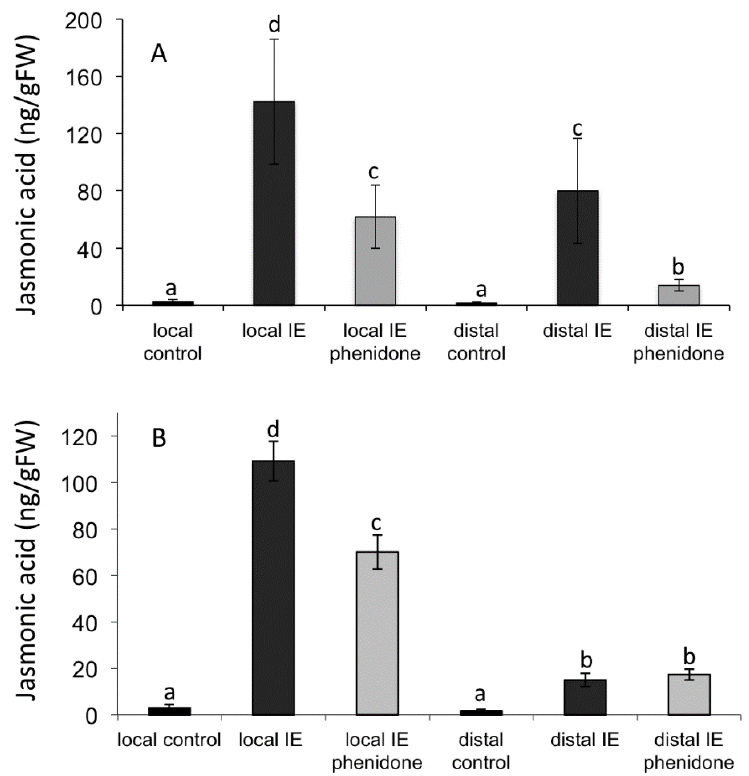
Figure 3. ( A ) Effect of cut stem application of phenidone on local and distal signaling after treatment with insect elicitor (IE); ( B ) Effect of local application of phenidone on local and distal signaling after treatment with IE. Different letters above each bar indicate statistical difference determined by ANOVA analysis followed by Tukey tests where appropriate ( p < 0.05). N = 3, error bars represent standard deviation.